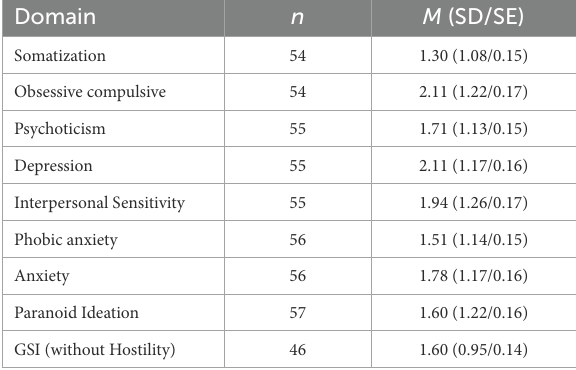
TABLE 2 The level of psychological distress among non-binary adolescents ( N =